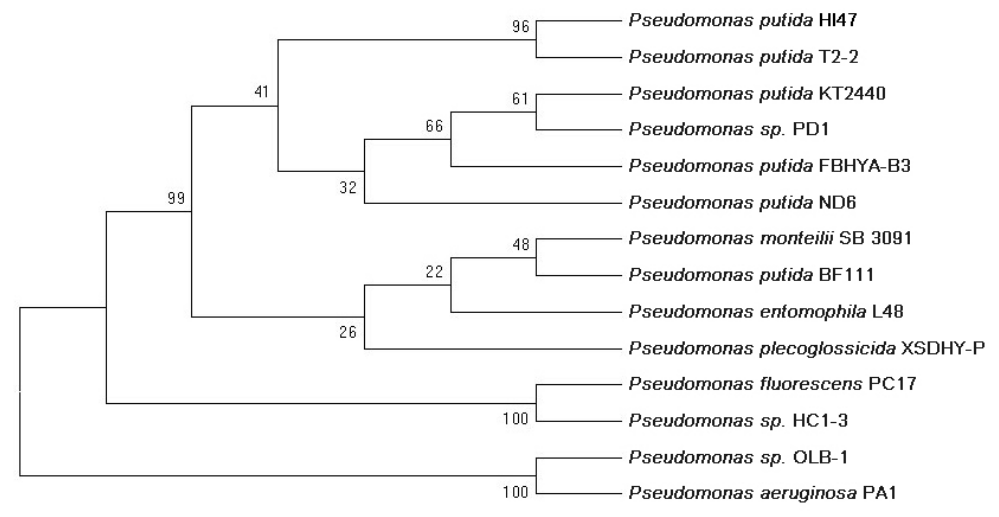
Figure 2. The phylogenetic tree of Pseudomonas strain homologues to the